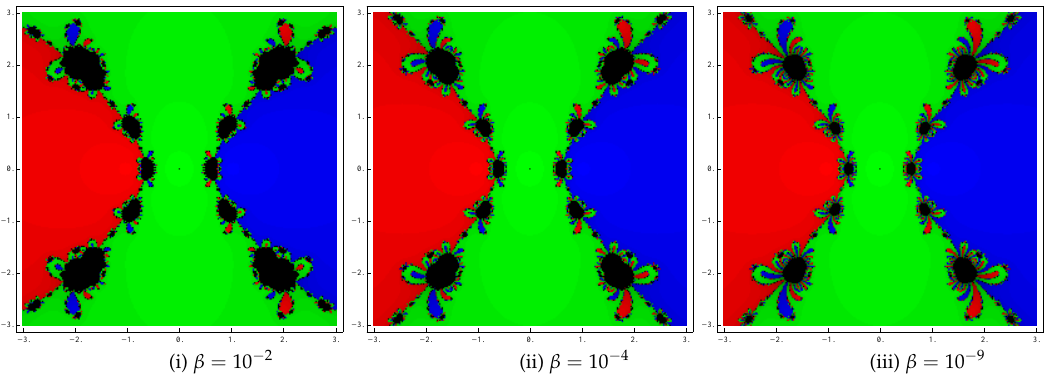
Figure 2. Basins of attraction of method for polynomial p 2 ( z )